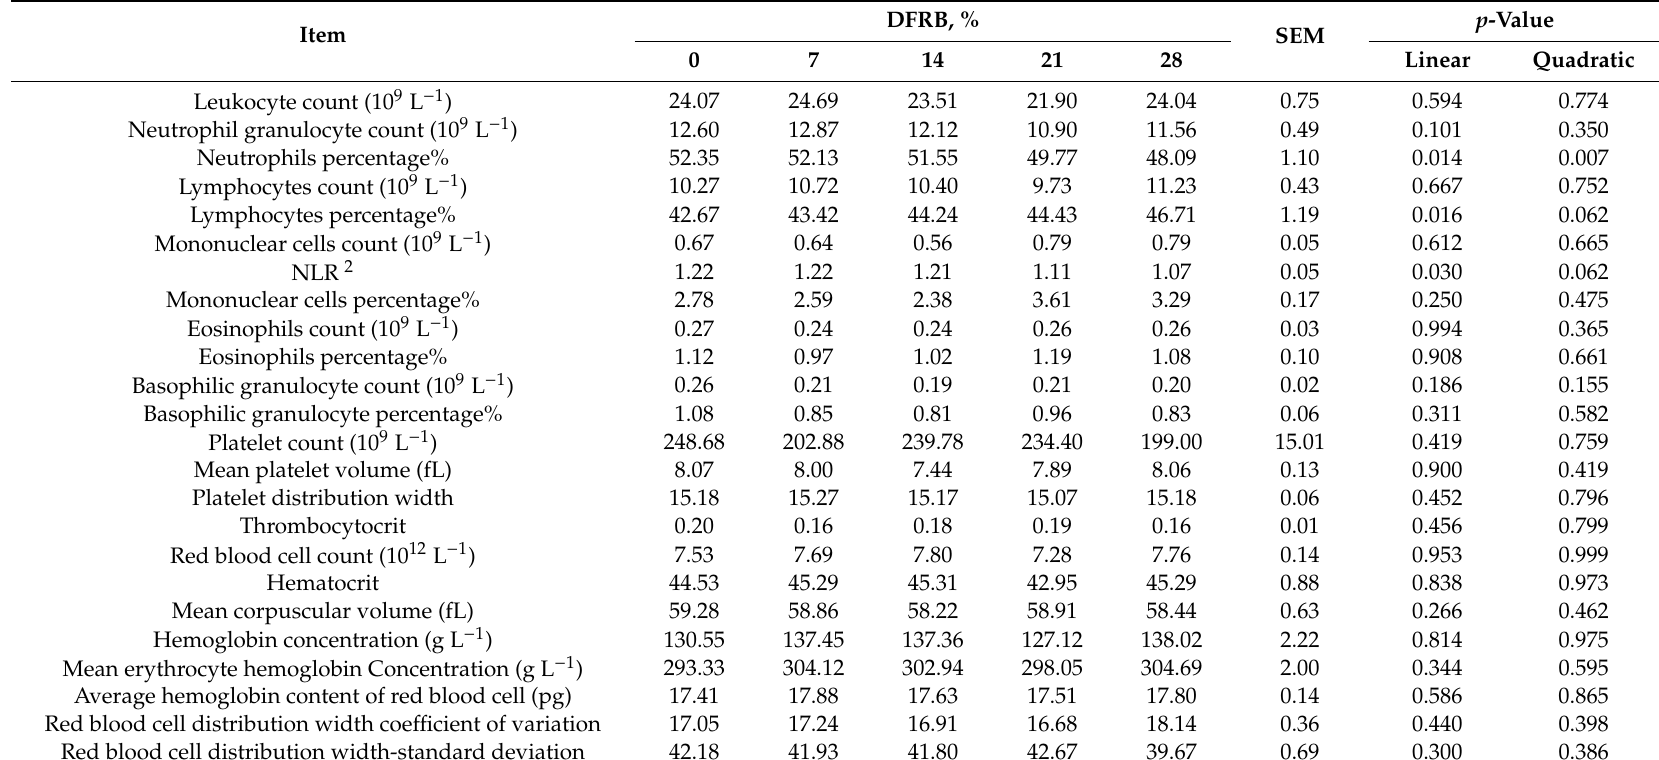
Table 3. E ff ects of increasing defatted rice bran (DFRB) supplementation on blood cell counts of finishing pigs 1